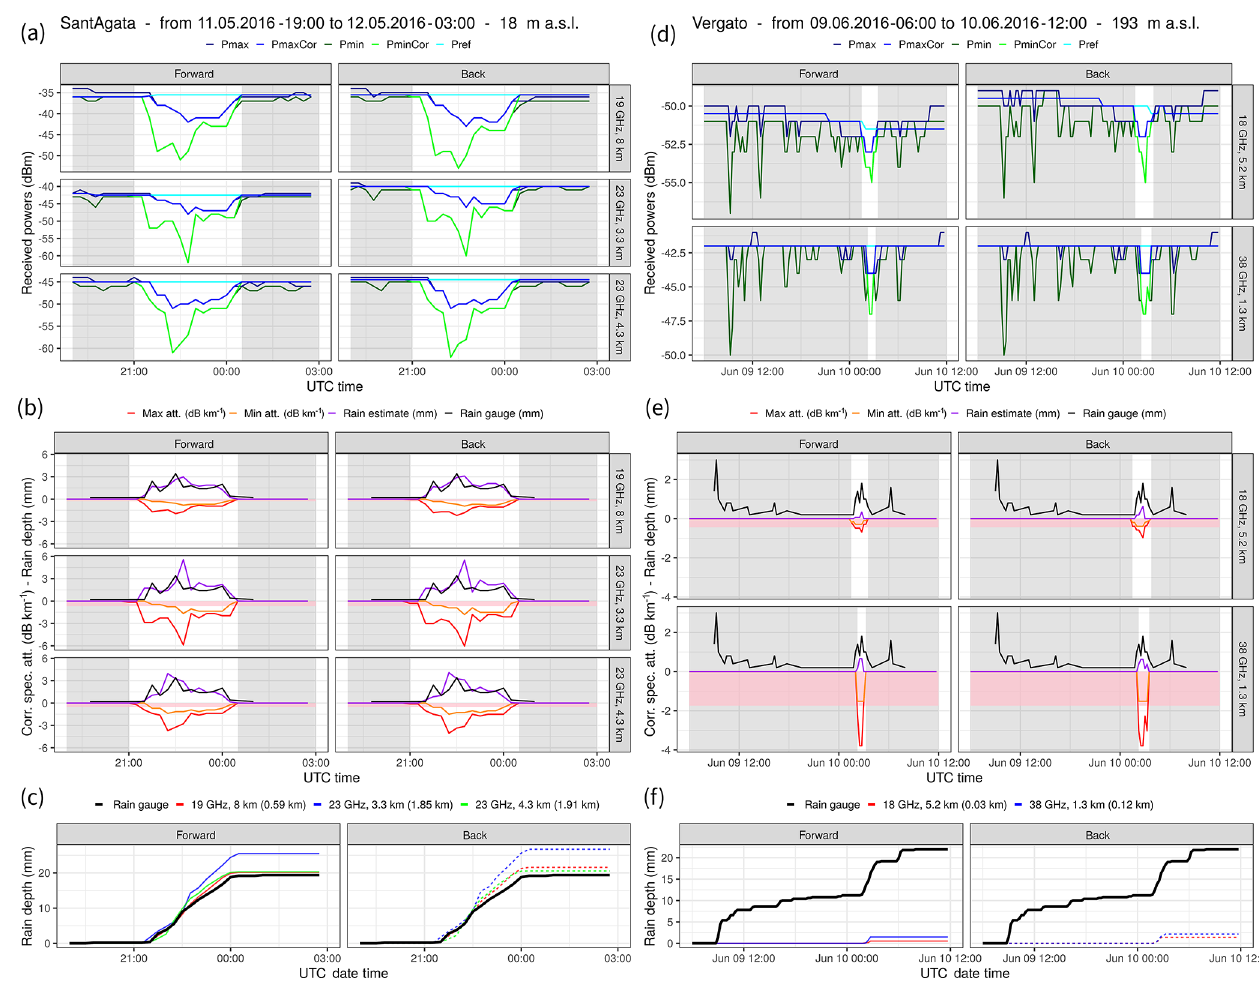
Figure 3. Single-link analysis for Sant’Agata (from 11 May 19:00UTC to 12 May 03:00UTC) and Vergato (from 9 June 06:00UTC to 10 June 12:00UTC): (a) and (d) show the received signals ( P max , dark blue; P Cor max , light blue; P min , dark green; P Cor cyan); (b) and (e) show maximum attenuation (red), minimum attenuation (orange), estimated rain rate (purple), and gauge measurements (black); in (c) and (f) the cumulated rain gauge rain rate (black) is plotted with the link estimates. Grey vertical bands correspond to intervals labelled as dry by the NLA classification; pink horizontal bands correspond to the threshold in decibels per kilometre of the wet-antenna correction of 2.3dB. The y -axis ranges are specific for each CML as received powers differ between different path